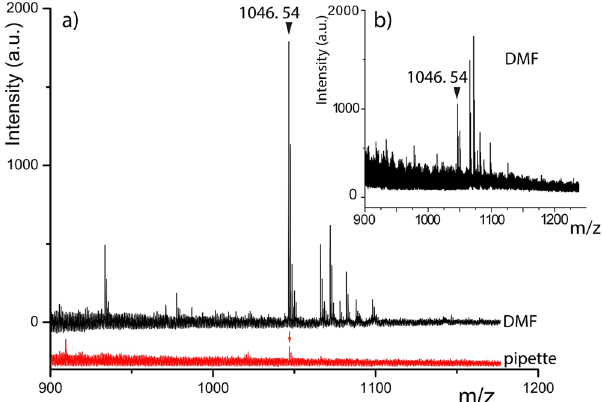
Figure 4. MALDI-TOF MS spectra of: ( a ) a 0.5 nM solution of Ang II spotted by DMF (black line) and standard pipette (red line shifted for clarity), and ( b ) DMF spotting of 0.1 nM solution of Ang